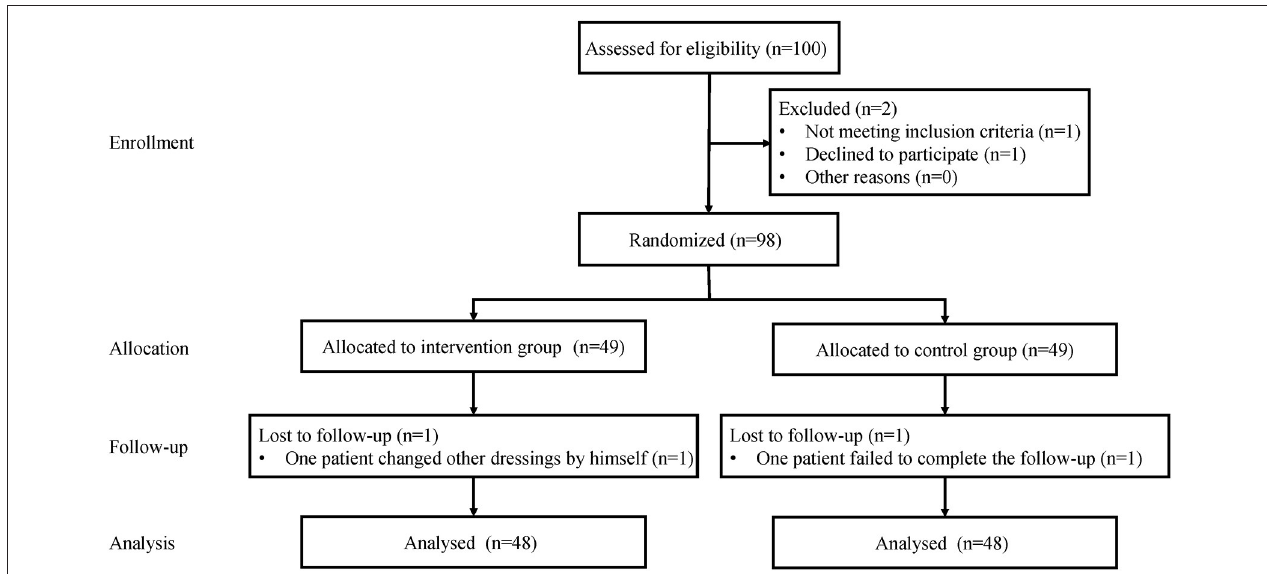
FIGURE 1 | Flow diagram of the allocation of patients to the intervention group (new dressing system group) and the control group (the traditional gauze dressing group).